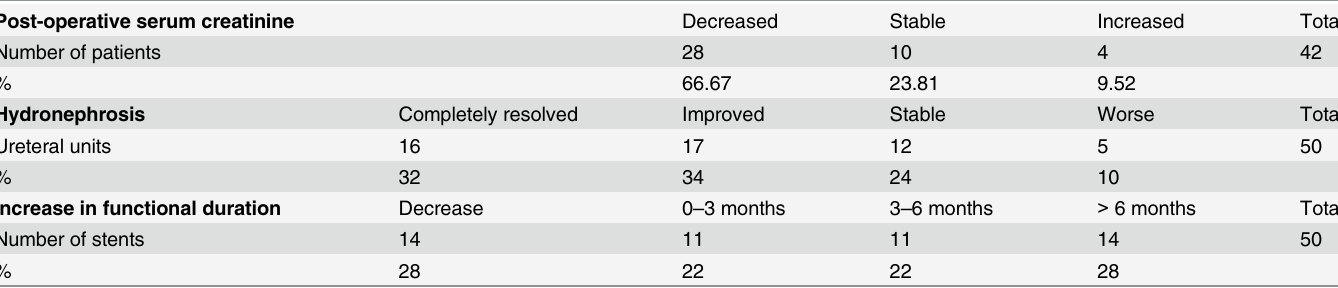
Table 2. The functional outcomes of the patients and the metallic stents.